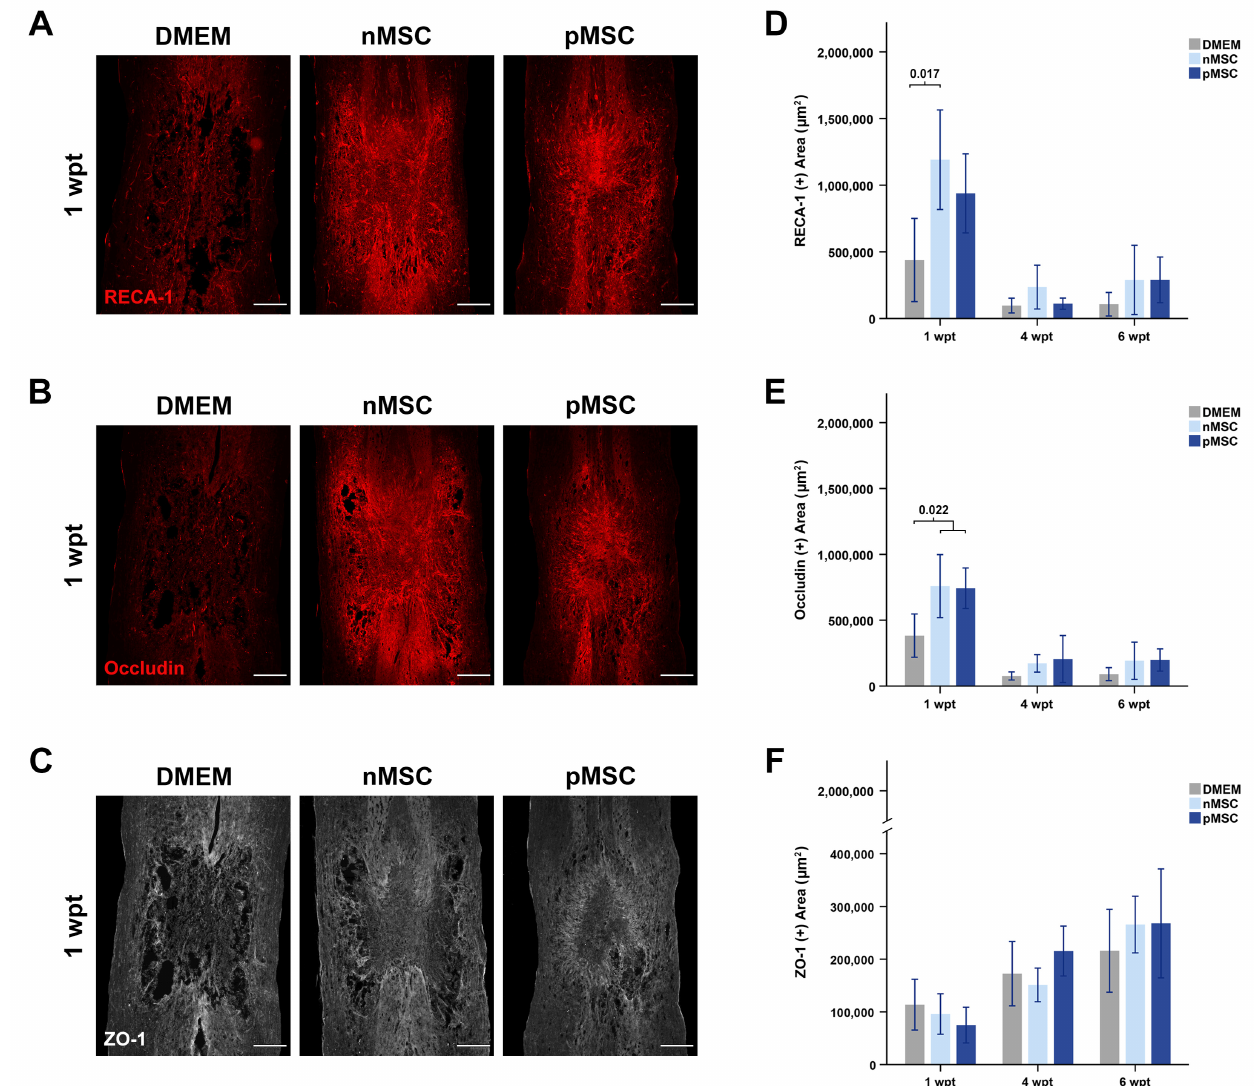
Figure 5. pMSC and nMSC transplants promote angiogenesis at 1 wpt. ( A – C ) Example photomicrographs of injured spinal cords at 1 wpt. The spinal cords’ orientation is top–rostral and bottom–caudal. ( A ) Blood vessel presence in the injury was measured using RECA-1 (red) staining. ( B ) Blood vessel maturation in the injury was measured using occludin (red) staining, and ( C ). ZO-1 (white) staining. For ( A – C ), intensity was equally modified on all images for illustrative purposes only but not for quantitative analysis. Scale bars on all images represent 500 µ m (Overviews: 4 × , image scan: 20 × ). ( D ) Bar graph representing the area of RECA-1 in the epicenter of the injury over time. nMSC transplants result in almost three-fold more blood vessel presence compared to controls at 1 wpt. ( E ) Bar graph representing the area of occludin in the injury epicenter over time. nMSC and pMSC transplants result in two-fold more occludin presence compared to controls at 1 wpt. ( F ) Bar graph representing the area of ZO-1 in the injury epicenter at 1 wpt. No significant differences were found between groups. In ( D – F ), bars represent the mean and SEM, and significance was accepted at p < 0.05. n = 6 per group and time point. Abbreviations: DMEM: Dubbelco’s Modified Eagle’s Medium; nMSC: naïve MSC; pMSC: primed MSC; wpt: